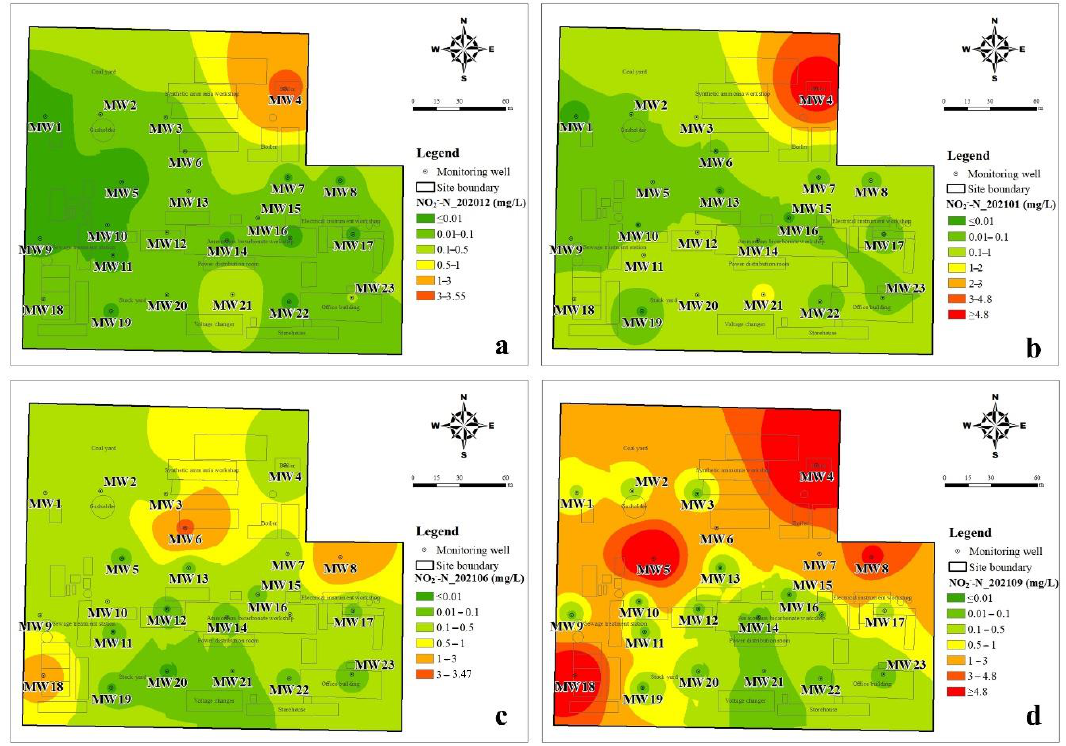
Figure 6. Interpolation diagram of nitrite-nitrogen in groundwater ( a ): in December 2020, ( b ): in January 2021, ( c ): in June 2021, ( d ): in September 2021.